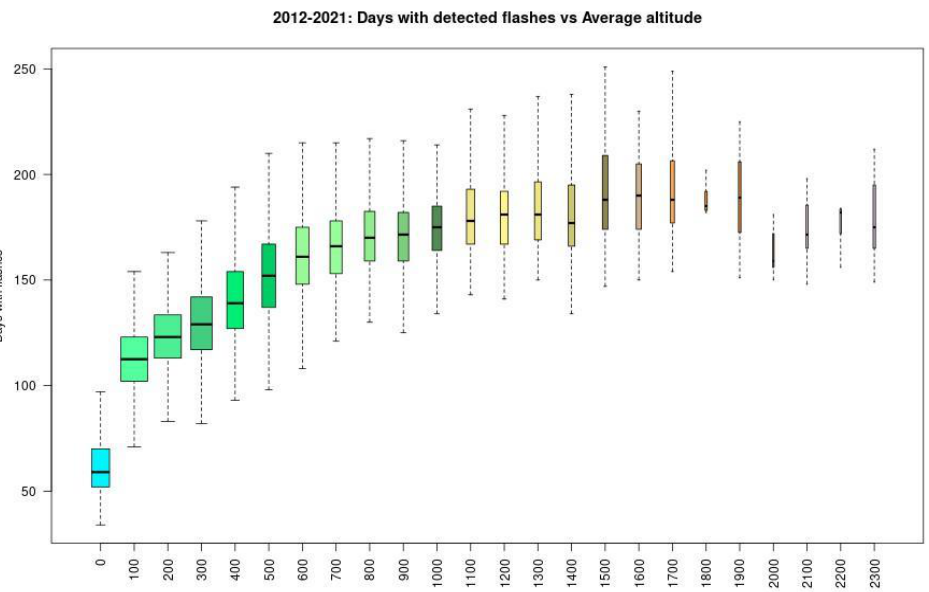
Figure 12. Box and whiskers plot of the number of days with detected flashes for the period 2012–2021 as a function of the average (on the grid of 0.05 × 0.05 deg) height in